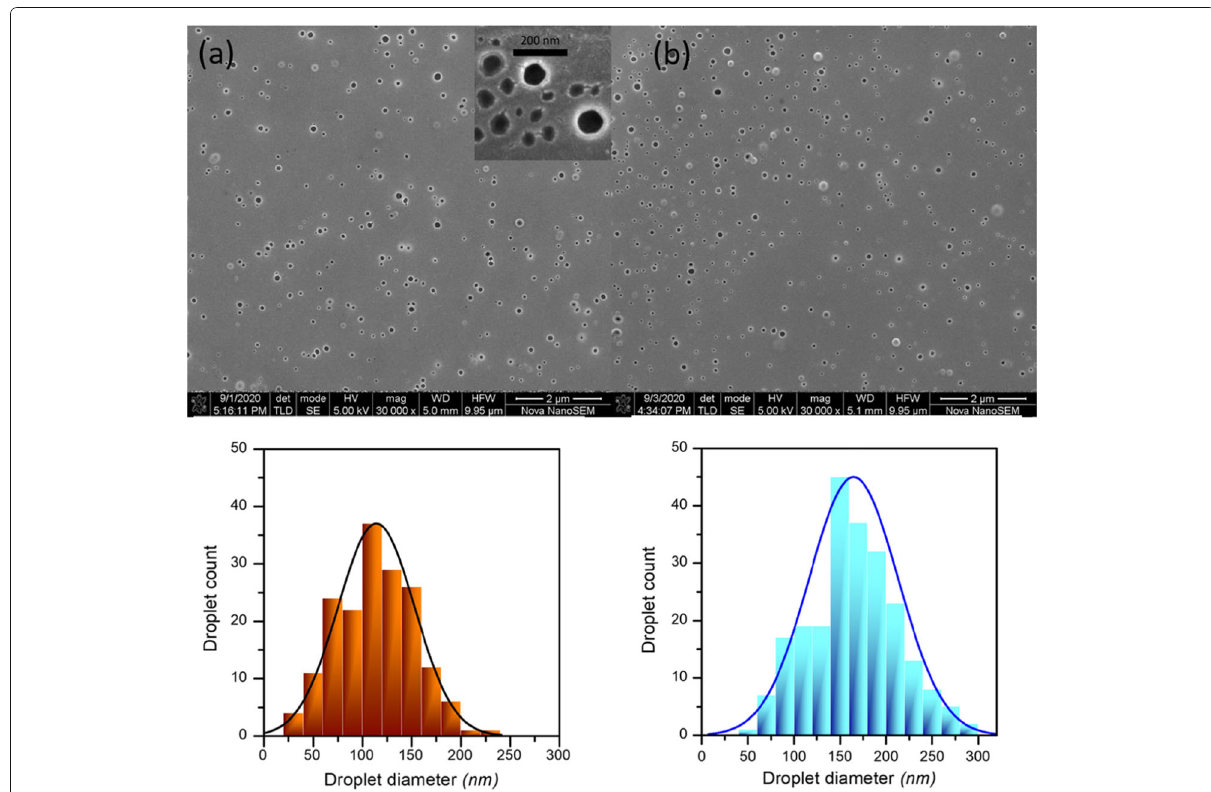
Fig. 6 a SEM of the optimized nanoemulsion, showing lipid phase droplets; (inset) close-up of the nanoemulsion droplets; b SEM of the nanoemulsion in the presence of 50 mM CaCl 2 . Size distribution profiles are underneath the respective SEMs